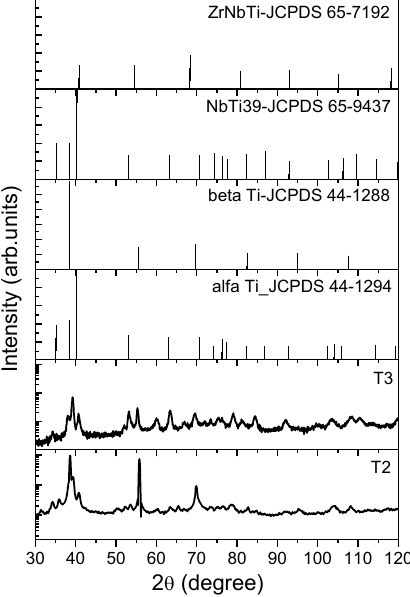
Figure 2. X-ray diffraction patterns of cast (T2) and annealed (T3) TiNbZr alloy.